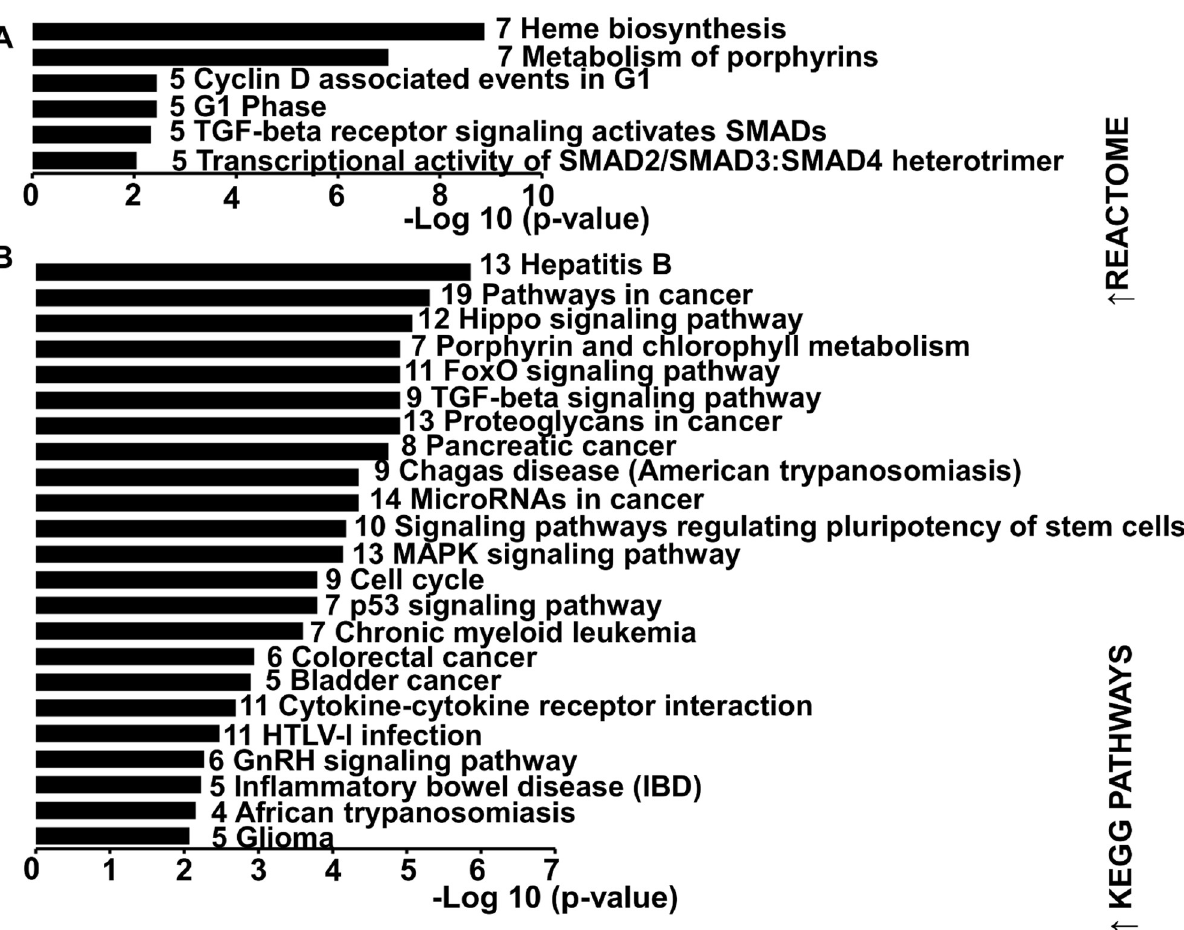
Fig 7. Functional analysis of predicted targets of down- and up-regulated miRNAs. A and B: Significant over-represented canonical pathways for down-regulated gene targets of up-regulated miRNAs according to Reactome and KEGG database, respectively. Pathways are ranked by score (-log10 ( P -value)). A higher score indicates that the pathway is more significantly associated with genes of interest. Numbers inside the end of each bar indicate the number of genes involved in each